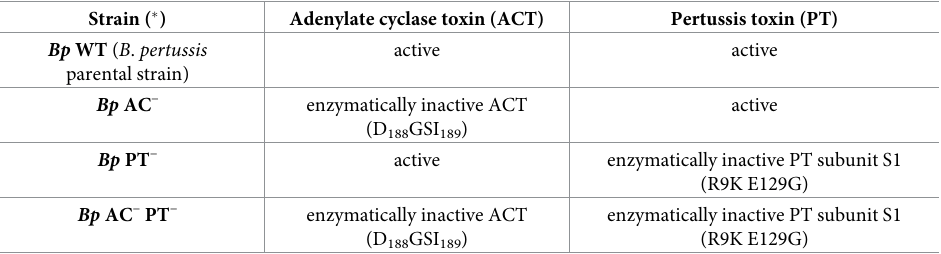
Table 1. B . pertussis strains used in this